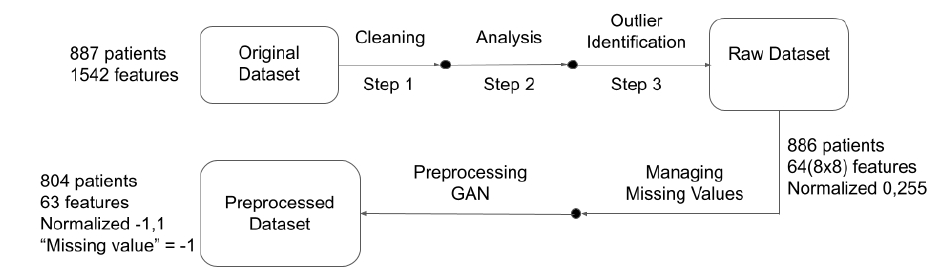
Figure 5. Representation of the total preprocessing carried out from the original dataset to the one employed to feed the GANs.